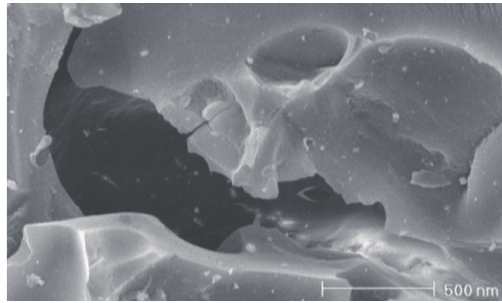
F 1: e X-ray diffraction patterns of the SPC (a) and Pd/SPC (b).